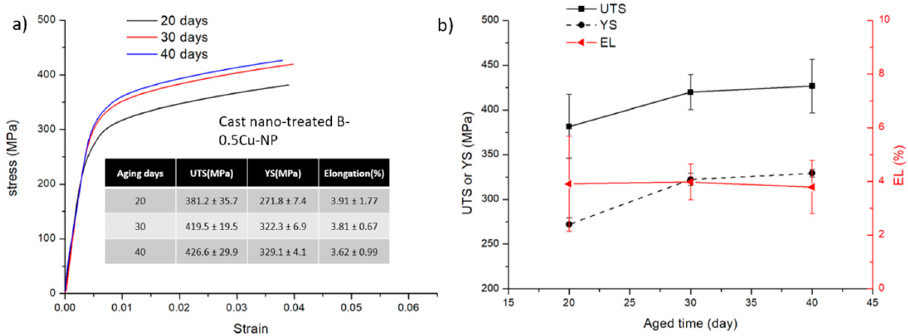
Figure 7. ( a ) Tensile testing of the nano-treated B-0.5Cu-NP samples aged 20, 30, and 40 days after casting. The inserted table contains tensile data. ( b ) Comparison of the corresponding UTS, YS, and EL values of each sample.